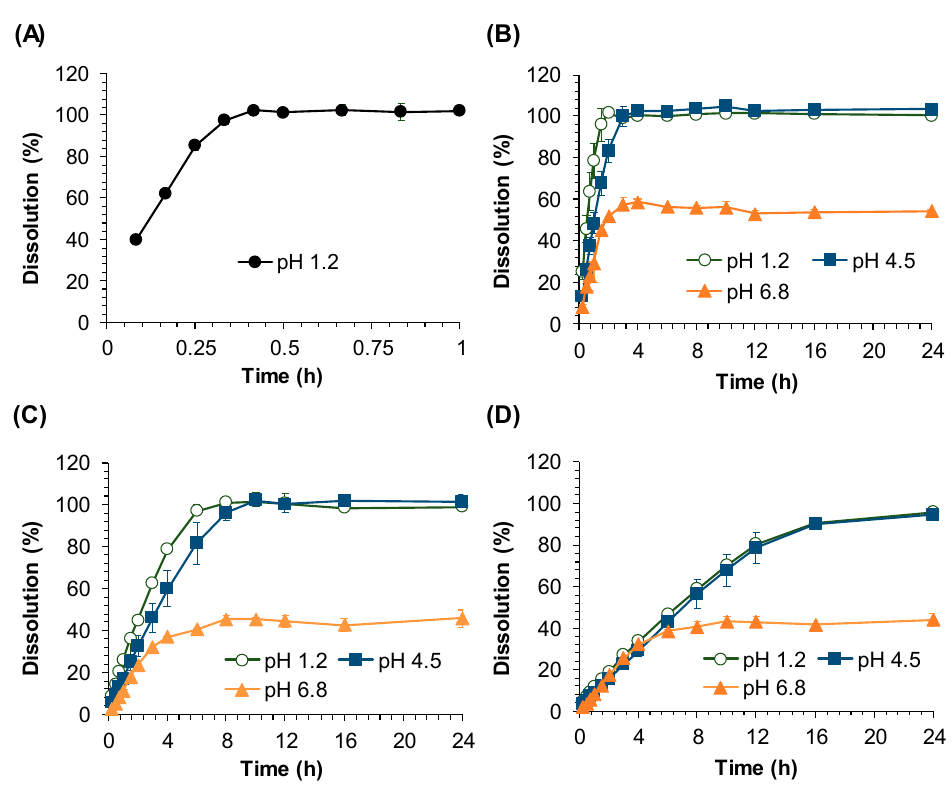
Figure 2. In vitro dissolution profiles of sildenafil from ( A ) Immediate Release (IR) tablet at pH 1.2 medium, ( B ) Sustained Release (SR) SR fast , ( C ) SR medium , and ( D ) SR slow tablets at pH 1.2, 4.5, and 6.8 media.